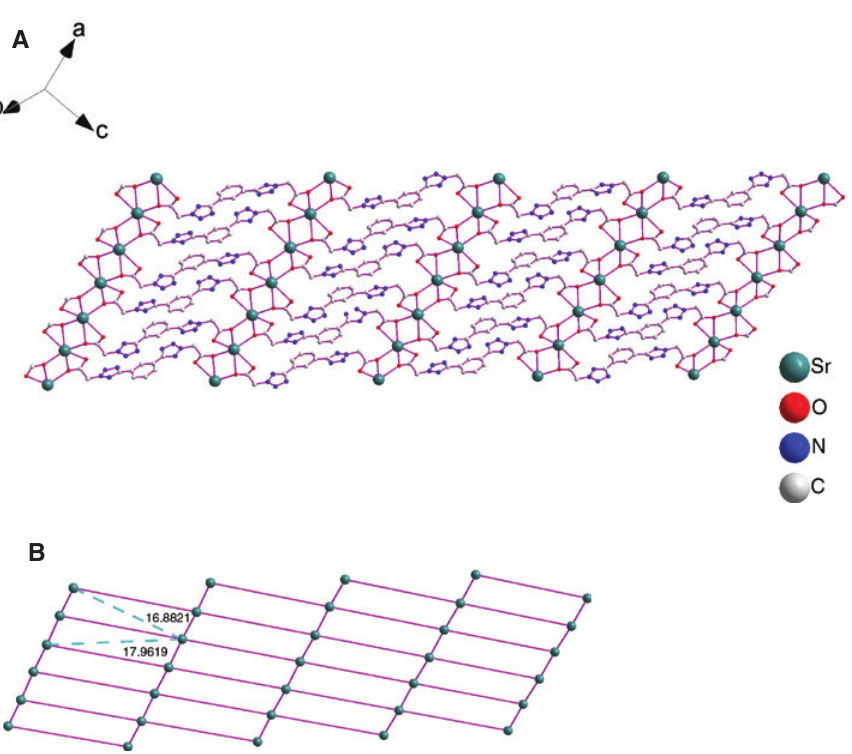
Figure 5: (A) The 2D chain structure of 2 . Hydrogen atoms are omitted for clarity. (B) The (4,4) topology of compound 2 .